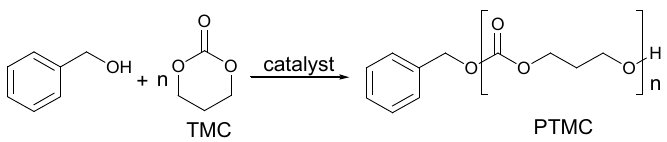
Figure 11. Benzyl alcohol initiator integrating with polymer structure.